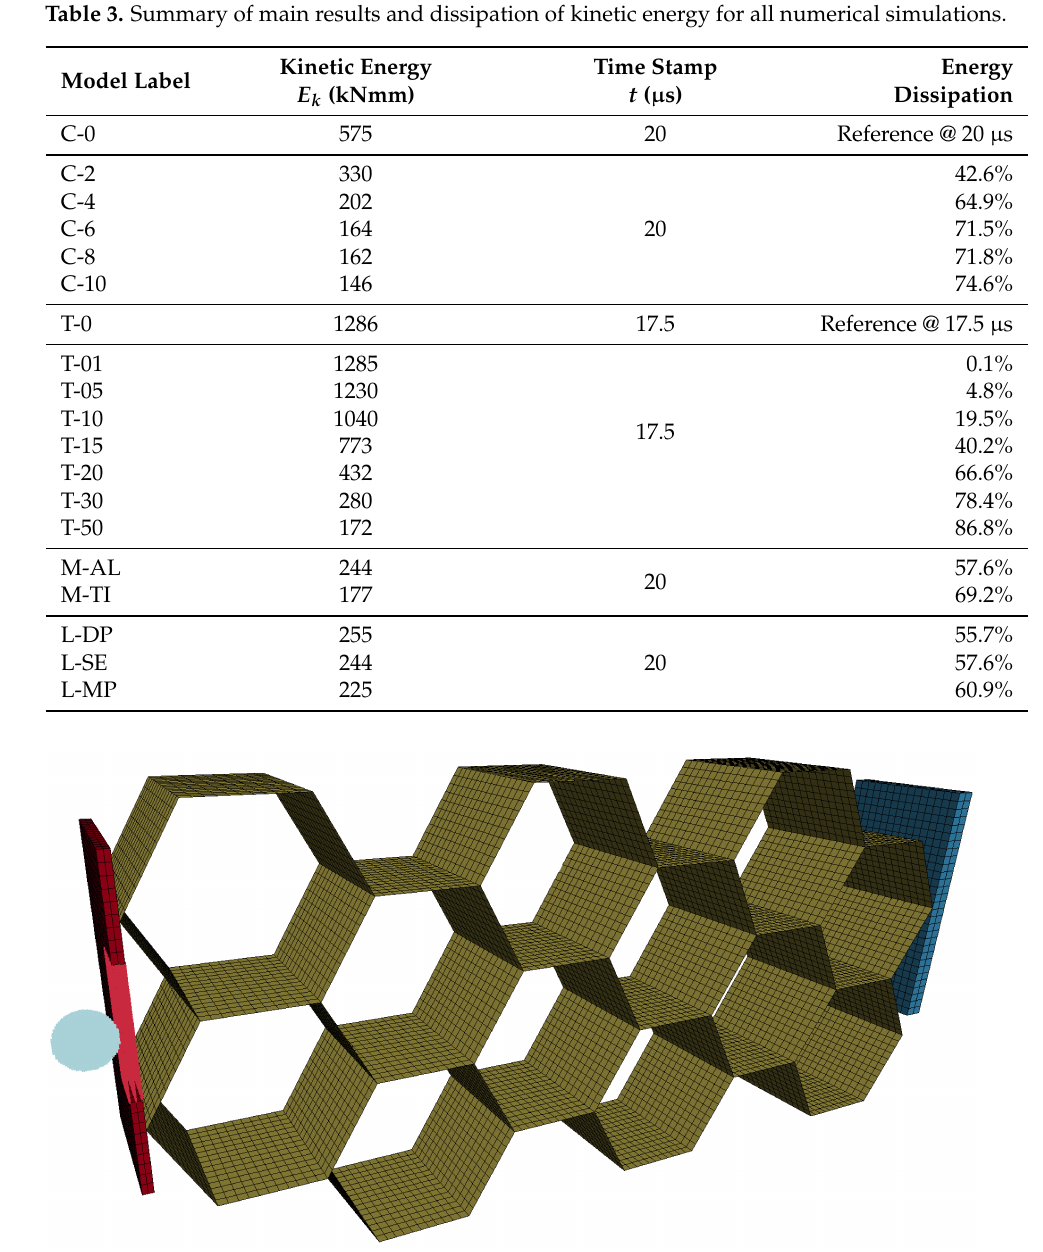
Figure 11. 3-dimensional view of model T-50, with a core cell density of 6 and a shell thickness t h = 0.5 mm (see Table